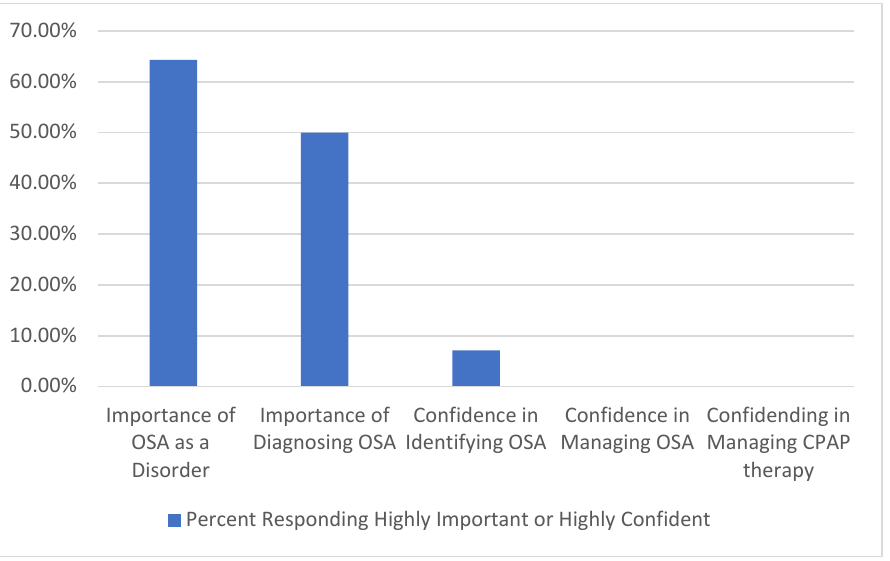
Figure 1. Percentage of Participants ( n = 14) Responding OSA is Highly Important or Have High Confidence in OSA Management.